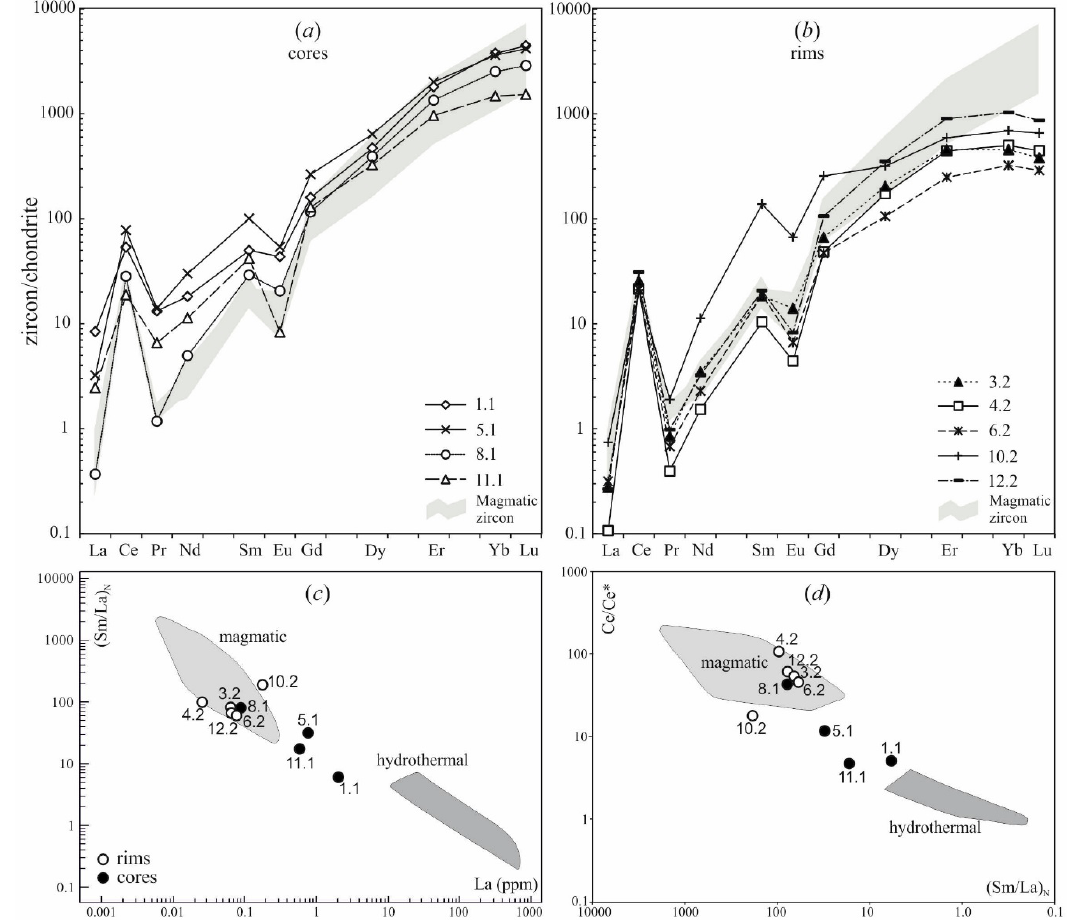
Figure 8. ( a ), ( b )—Chondrite-normalized REE patterns of zircon from the garnet quartzite, sample 823-1. Pattern numbers correspond to the numbers of analytical spots in Figure 6. The grey field corresponds to the composition of magmatic zircon according to [29]. (c ), ( d )—Diagrams for distinguishing magmatic zircon from the hydrothermal one according to [29].